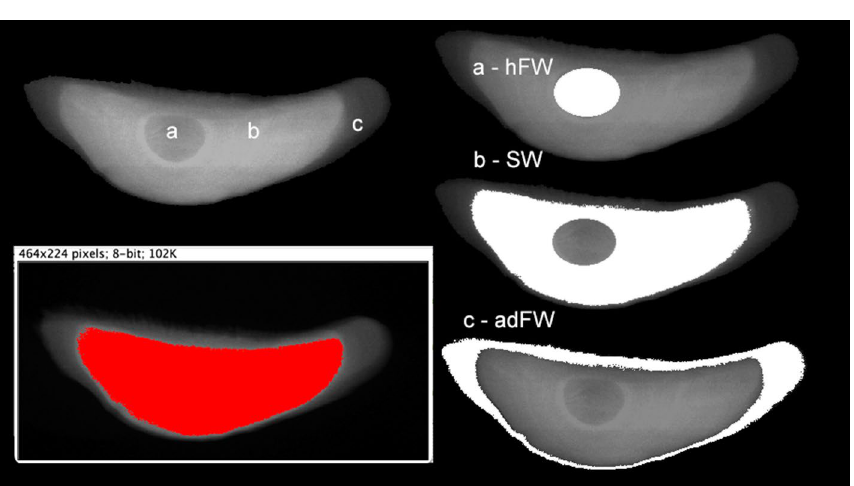
Figure 2. Sketch showing the design process for the delimitation of interest areas from the otolith samples. The specific masks were obtained by thresholding the XRF strontium (Sr) maps to fit in with the zonation exhibited in grey level scale (on the left). For each area a mask was created (right panel), with the central core ( a ), the high Sr content area ( b ) and the distal margin ( c ) respectively corresponding to ’hatching freshwater ’ (hFW), ’ sea water ’ (SW) and ’ adult freshwater ’ (adFW) conditions. These masks served as boundaries for discrete quantitative analysis on each designed region of